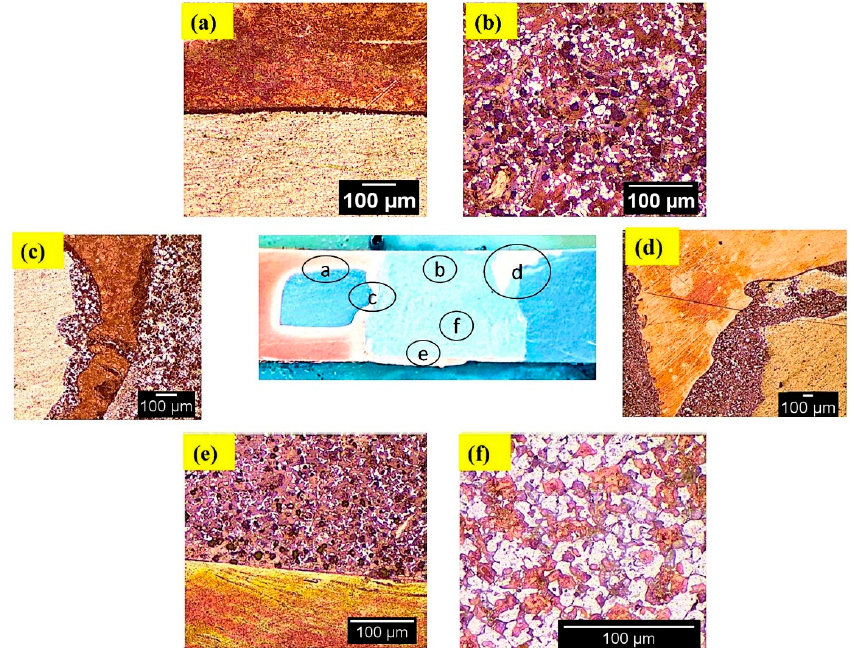
Figure 5. Microstructure in Al/Cu joint formed by CFSW at ( a , b , d ) top, ( c ) middle, ( e , f ) bottom.